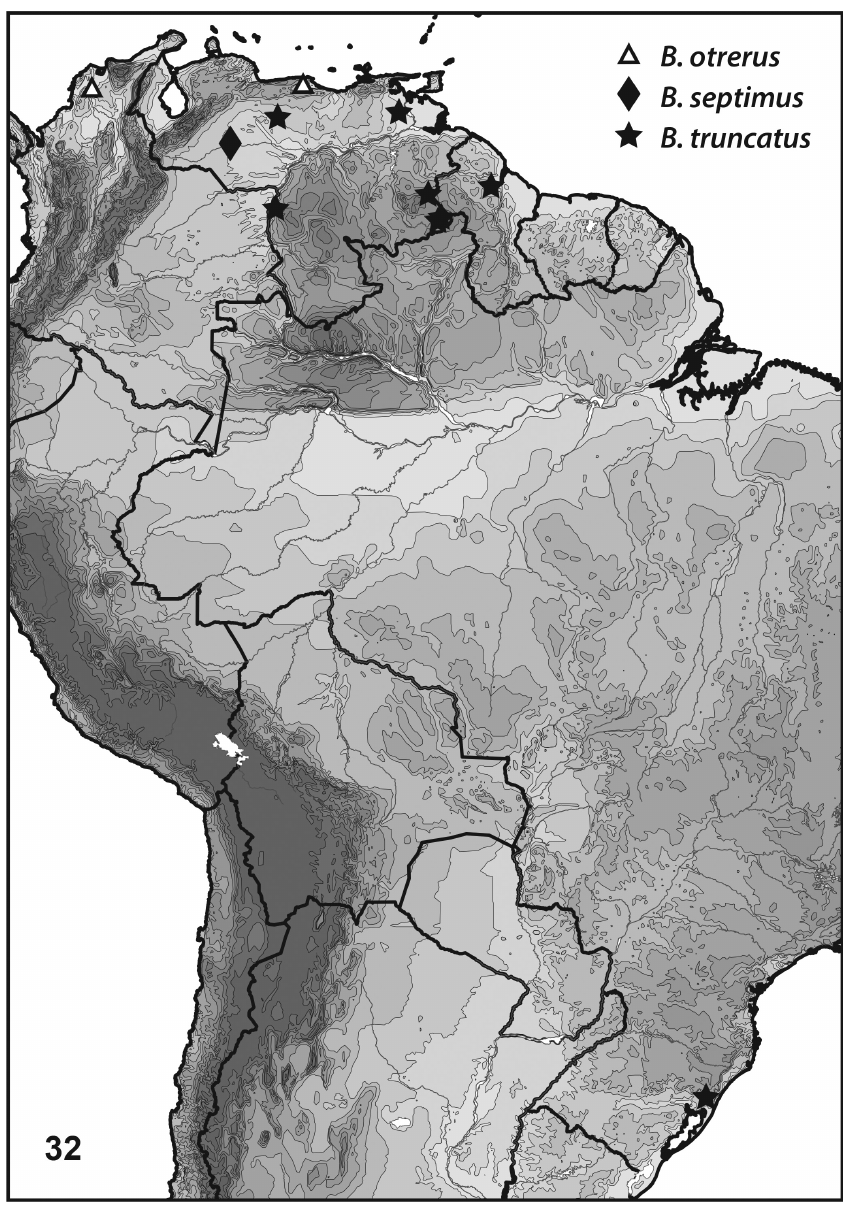
Figure 32. Bidessonotus species, South American